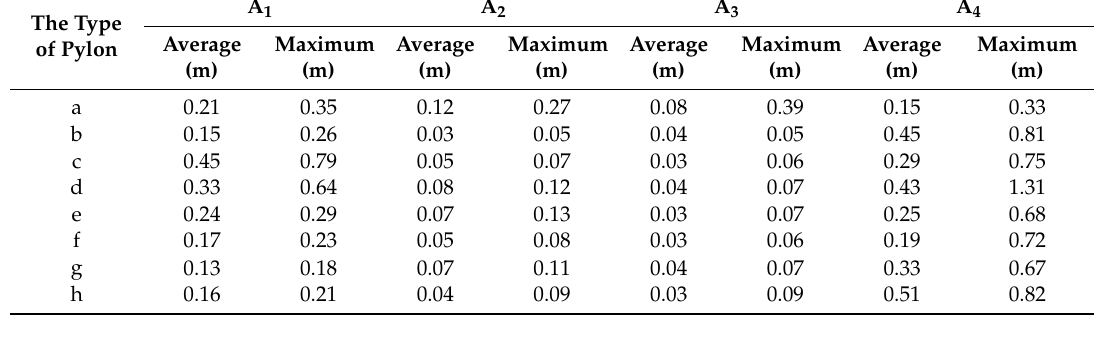
Table 10. Errors in the pylon reconstruction.